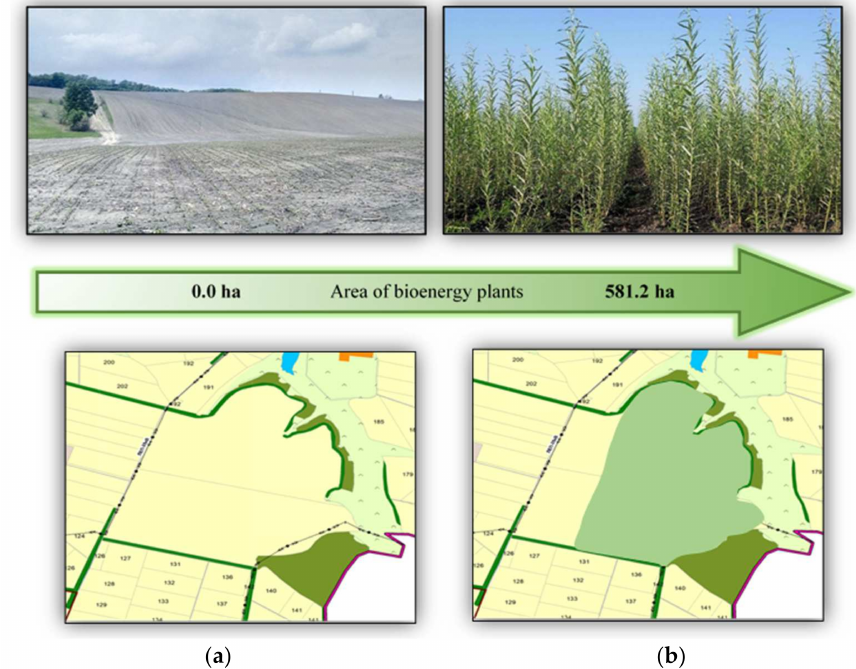
Figure 6. Projecting of bioenergy planting (willow) within the farming enterprise territory according to the bioenergy production scenario (photo: [53,54]): ( a ) Baseline scenario; ( b ) Land protection and bioenergy production